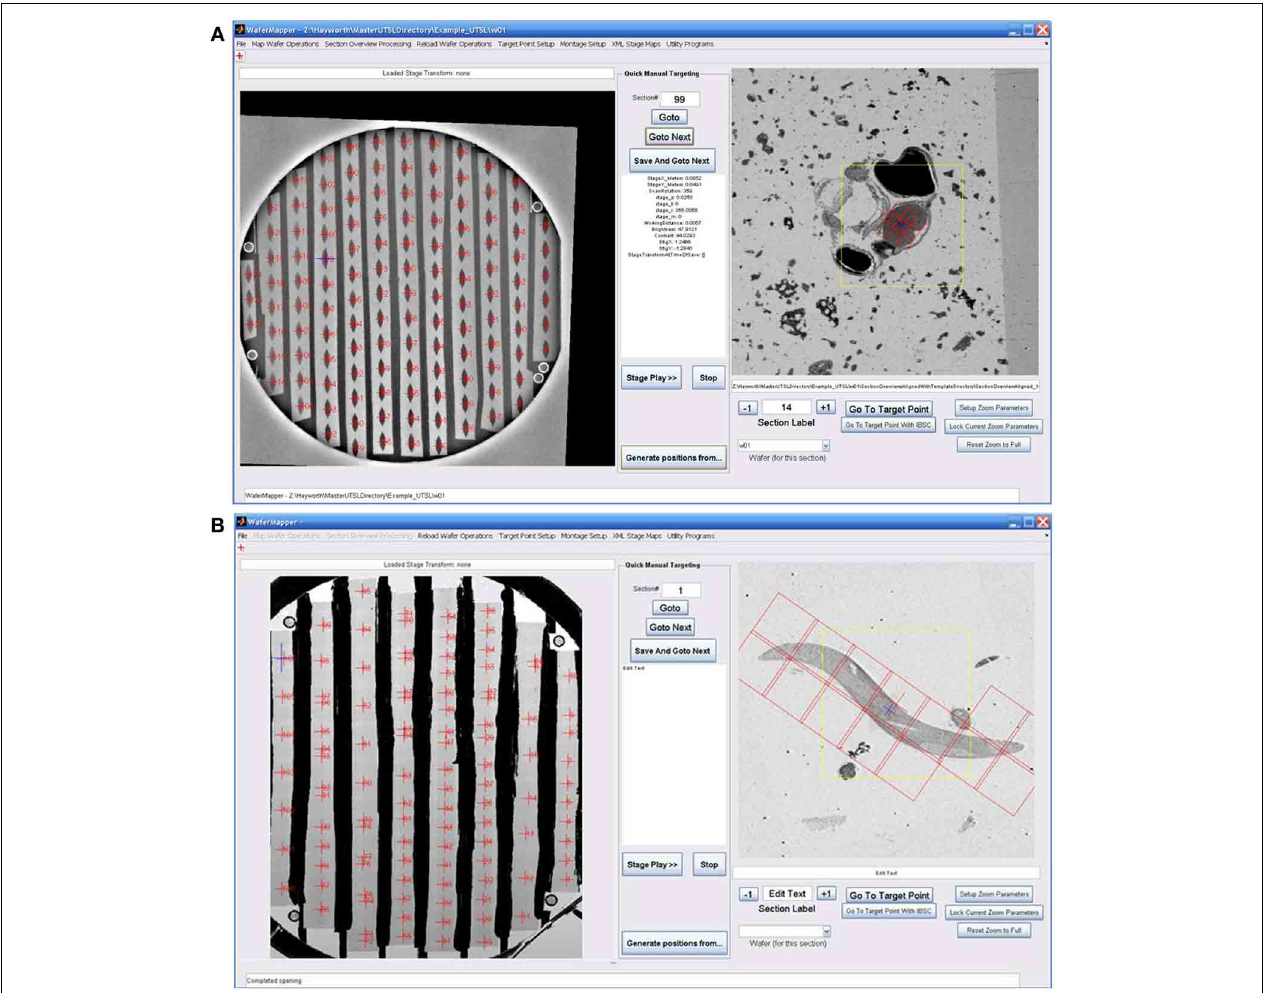
FIGURE 7 | Examples of graphically defining an imaging target and montage. (A) Image shows the WaferMapper GUI being used to graphically define a 3 × 3-tile montage (red boxes) covering just the brain region in a larval zebrafish UTSL. (B) Image shows WaferMapper used to graphically define a 3 × 7-tile montage (red boxes) covering a single worm in a C. elegans UTSL. Note the ability to selectively designate a subset of montage tiles for imaging. Of crucial importance is the